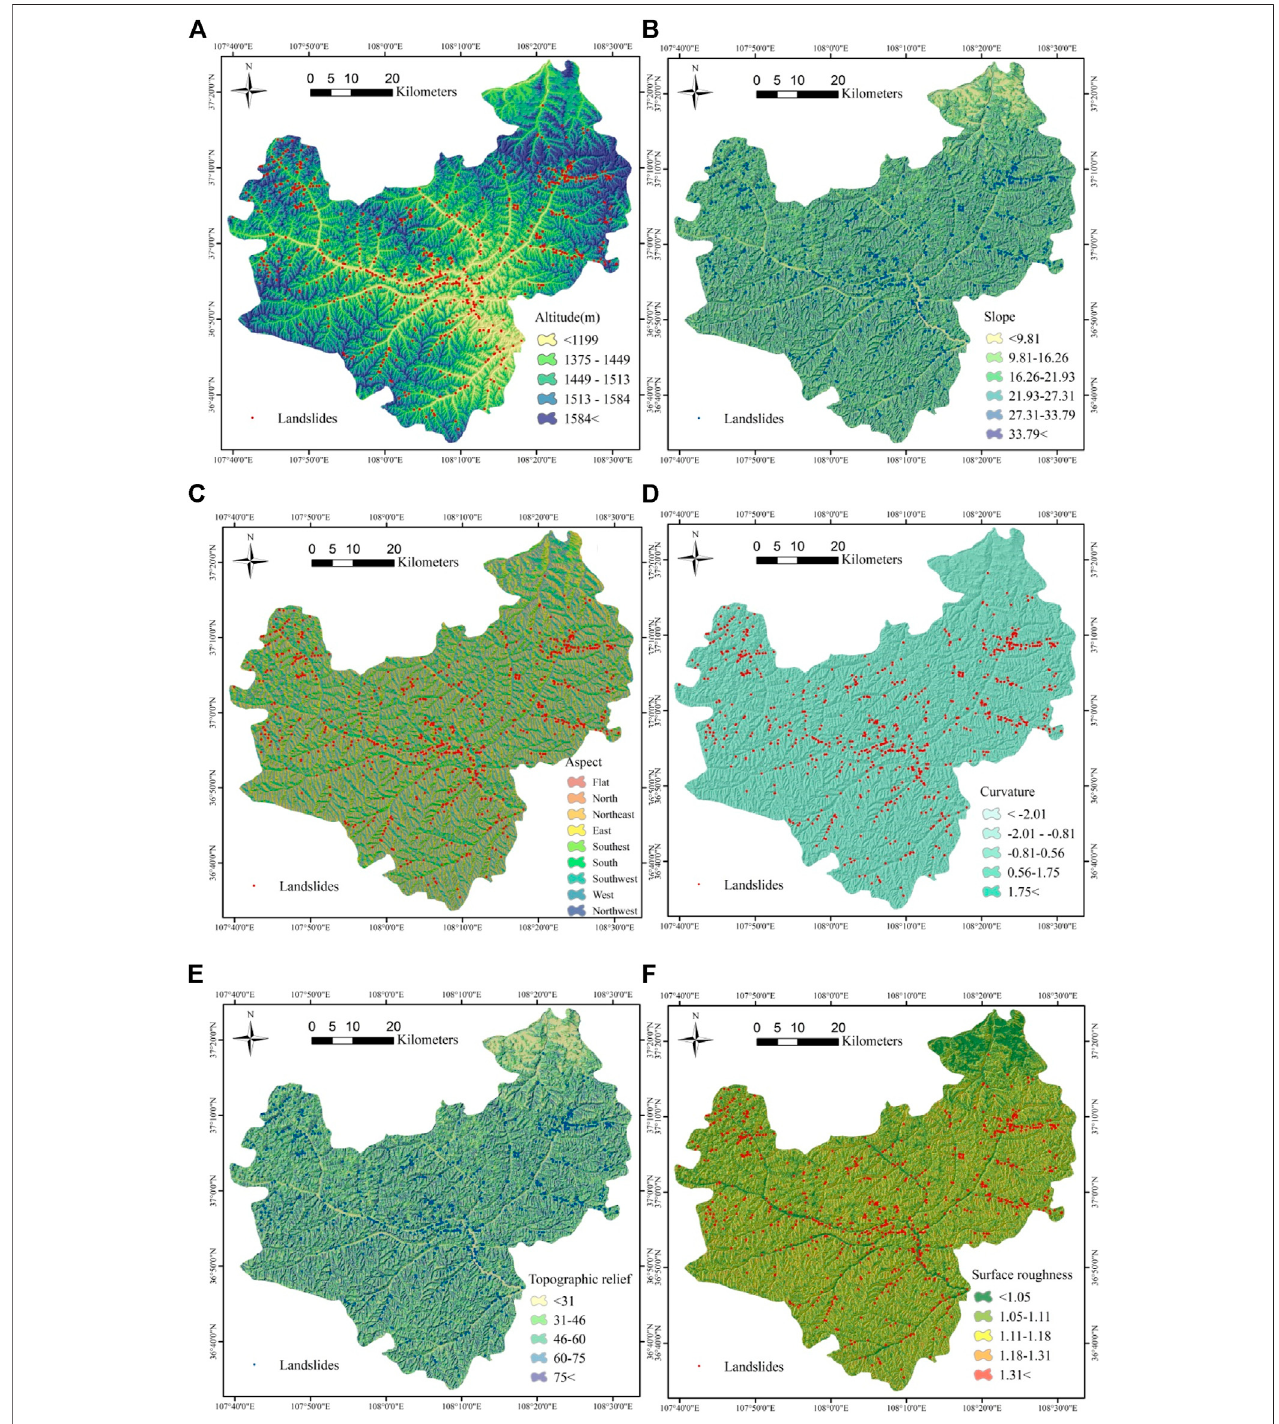
FIGURE 3 | Landslide in fl uencing factor maps. (A) Altitude, (B) Slope, (C) Aspect, (D) Curvature, (E) Topographic relief, (F) Surface roughness, (G) TWI, (H) HI, (I) Lithology, (J) Average annual rainfall, (K) Distance to rivers, (L) NDVI, (M) Distance to roads, (N) Distance to villages.